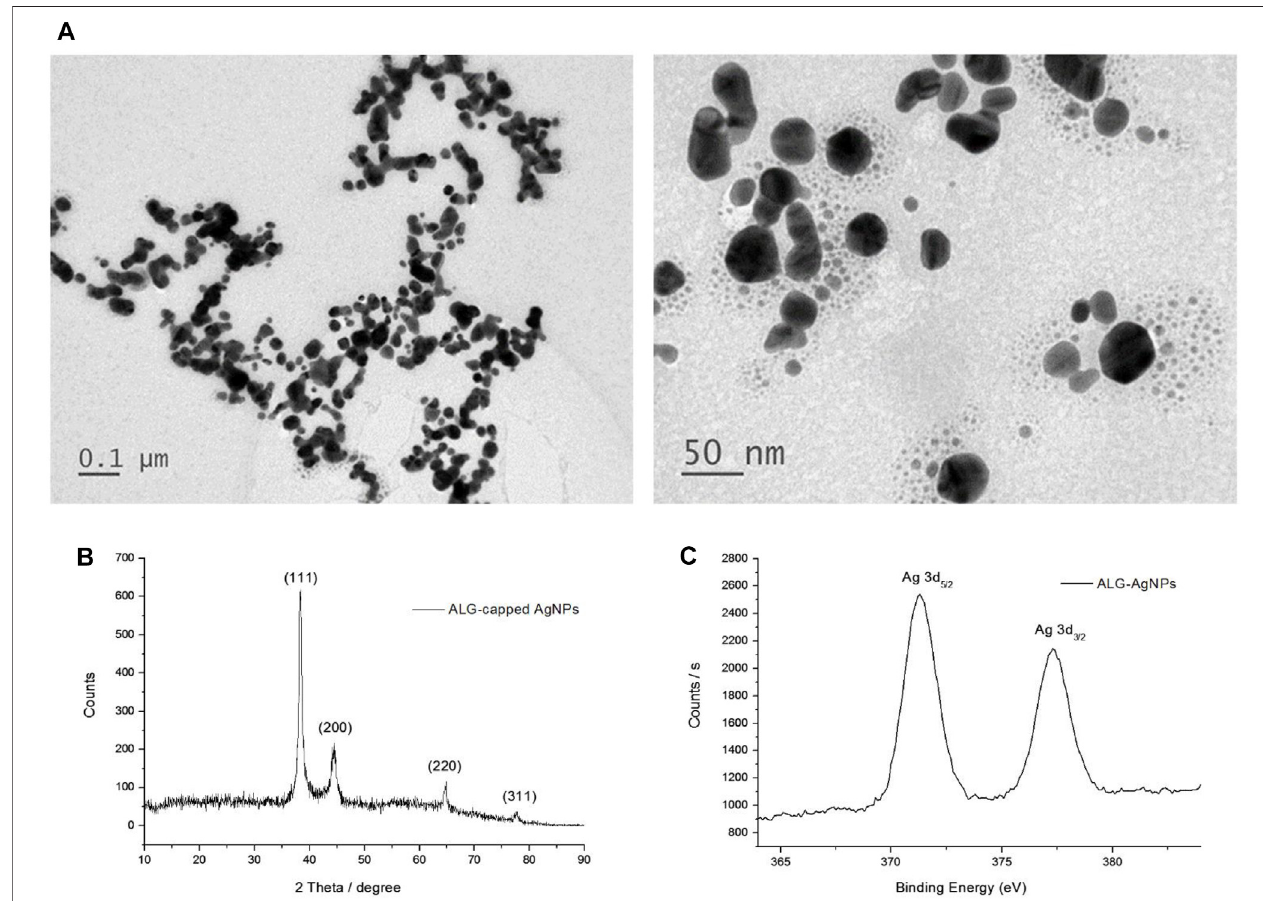
FIGURE 1 | Characterization of ALG-AgNP physical and chemical properties. (A) Transmission electron microscopy (TEM) imaging of ALG-AgNPs. (B) XRD spectrum of ALG-AgNPs. (C) XPS spectrum of ALG-AgNPs.